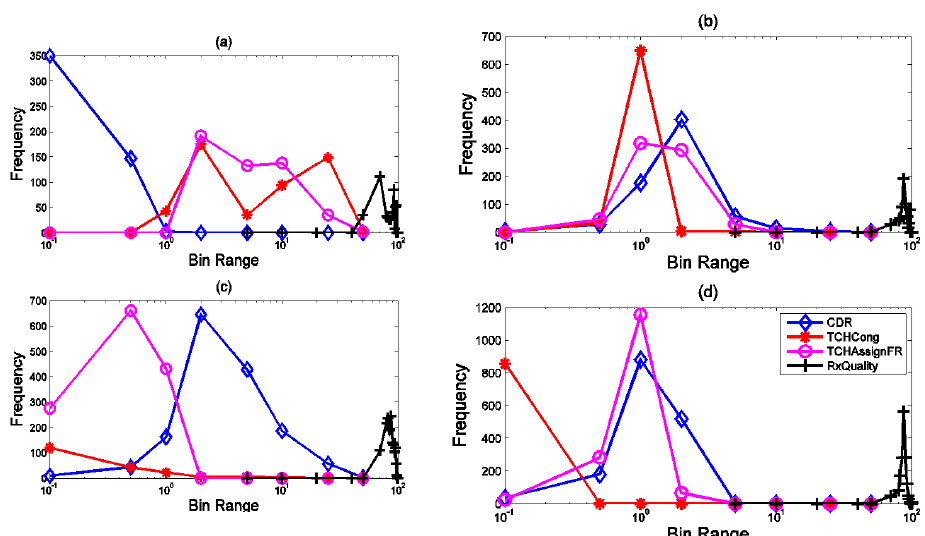
Figure 11. Indicators of statistical distribution of the signaling sector. Each cluster represents a mode of the network. of the